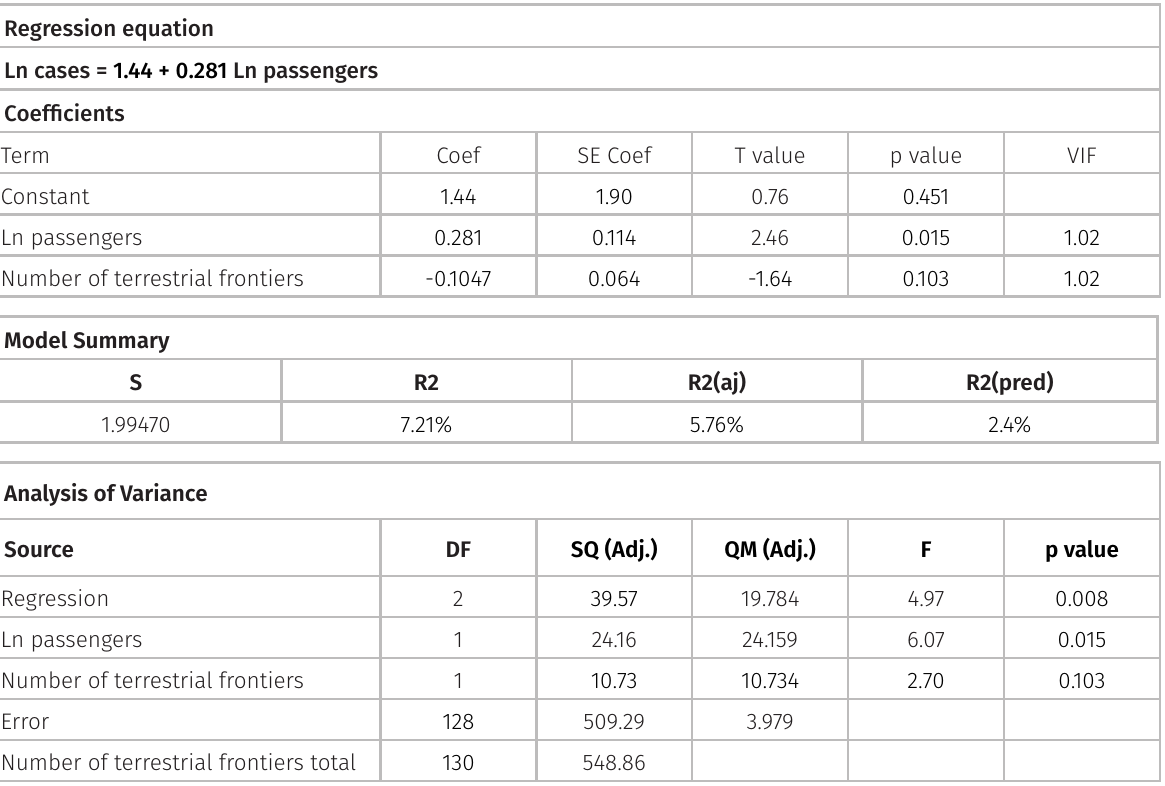
Table II. Stepwise regression summary for COVID-19 cases per 1 million inhabitants by passengers and international frontiers. Regression equation Ln cases = 1.44 + 0.281 Ln